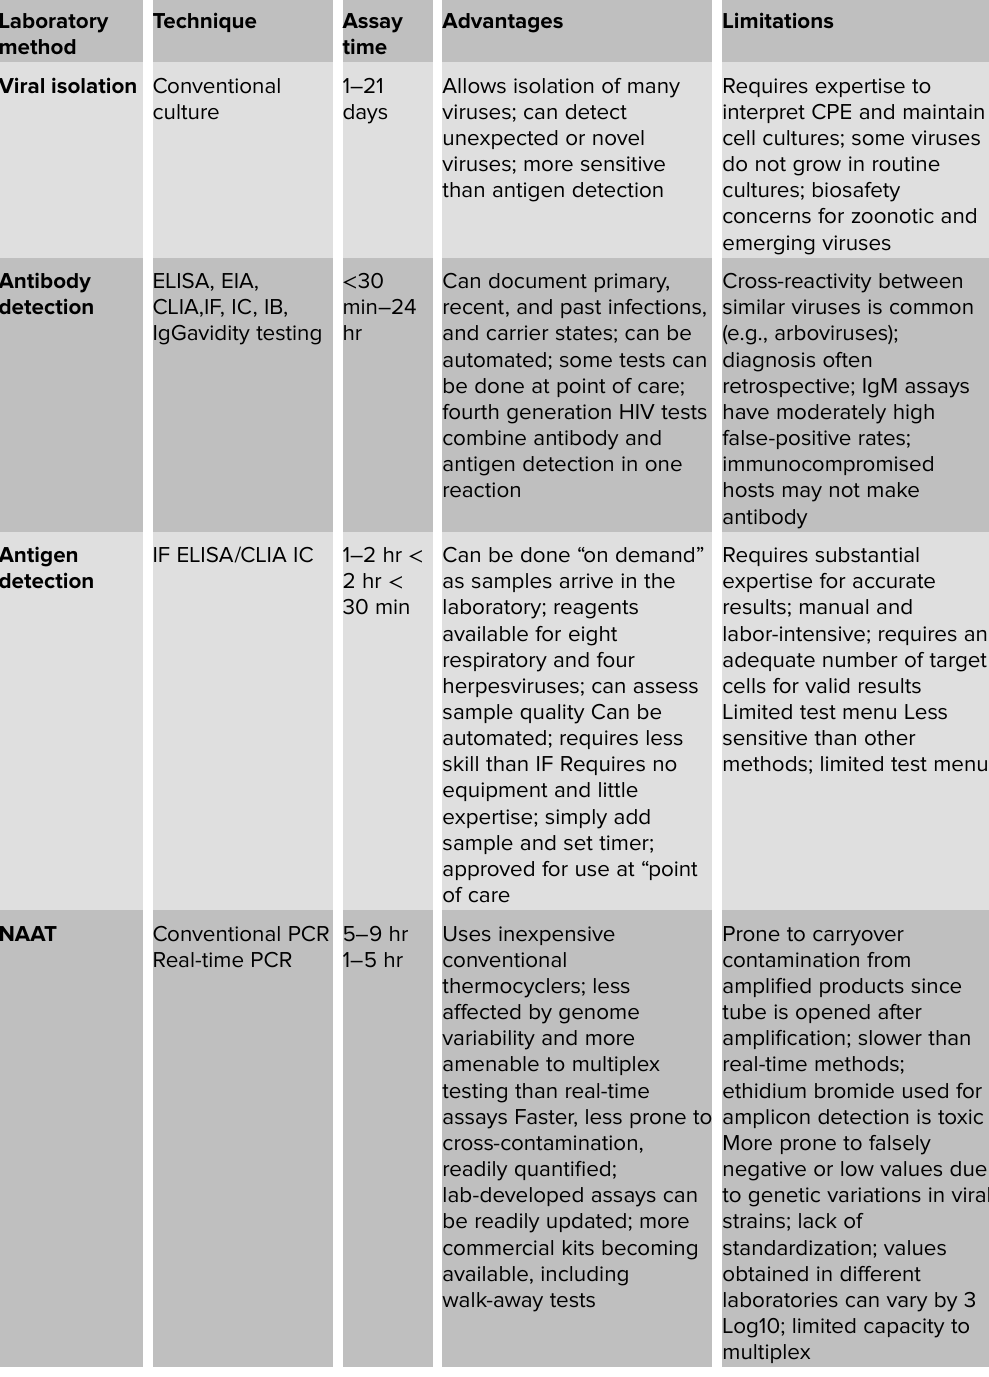
TABLE 1: Overview of viral diagnostic methods: advantages and